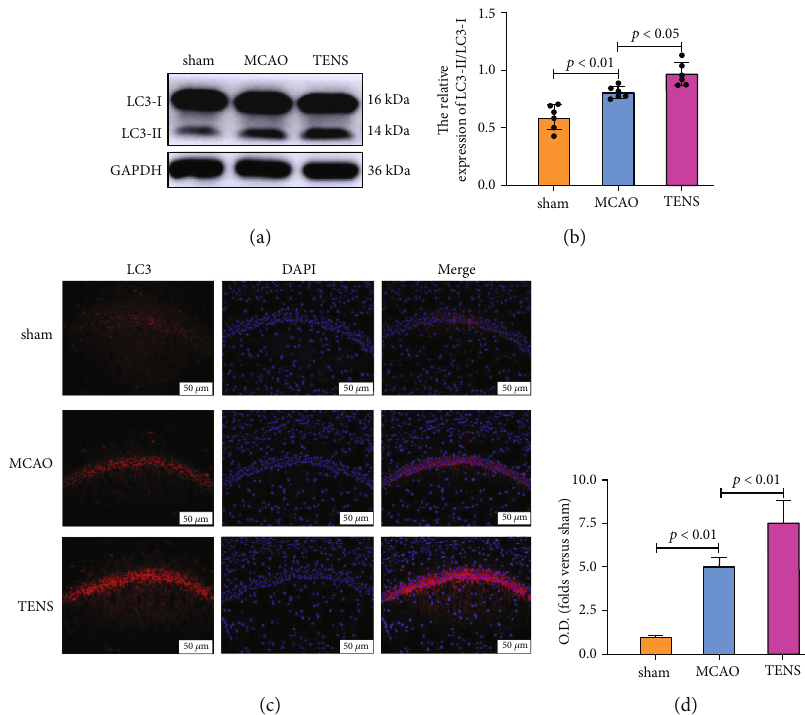
Figure 6: The e ff ect of TENS treatment on LC3 expression. (a) The expression of LC3-II/LC3-I was measured by western blot, in which GAPDH was used for the loading controls. (c) IF analysis exhibiting the expression di ff erence of LC3 protein in the ipsilateral hippocampus among three groups. (b, d) Statistical analysis of the expression of LC3 as assessed by IF.